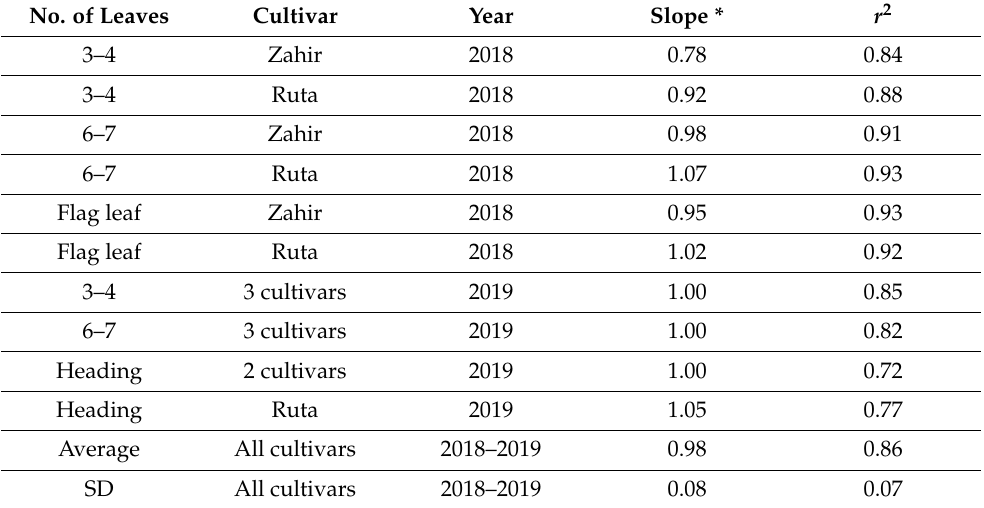
Table 3. Correlation between N uptake determined by the camera method and in the laboratory results from greenhouse (2018) and field (2019)